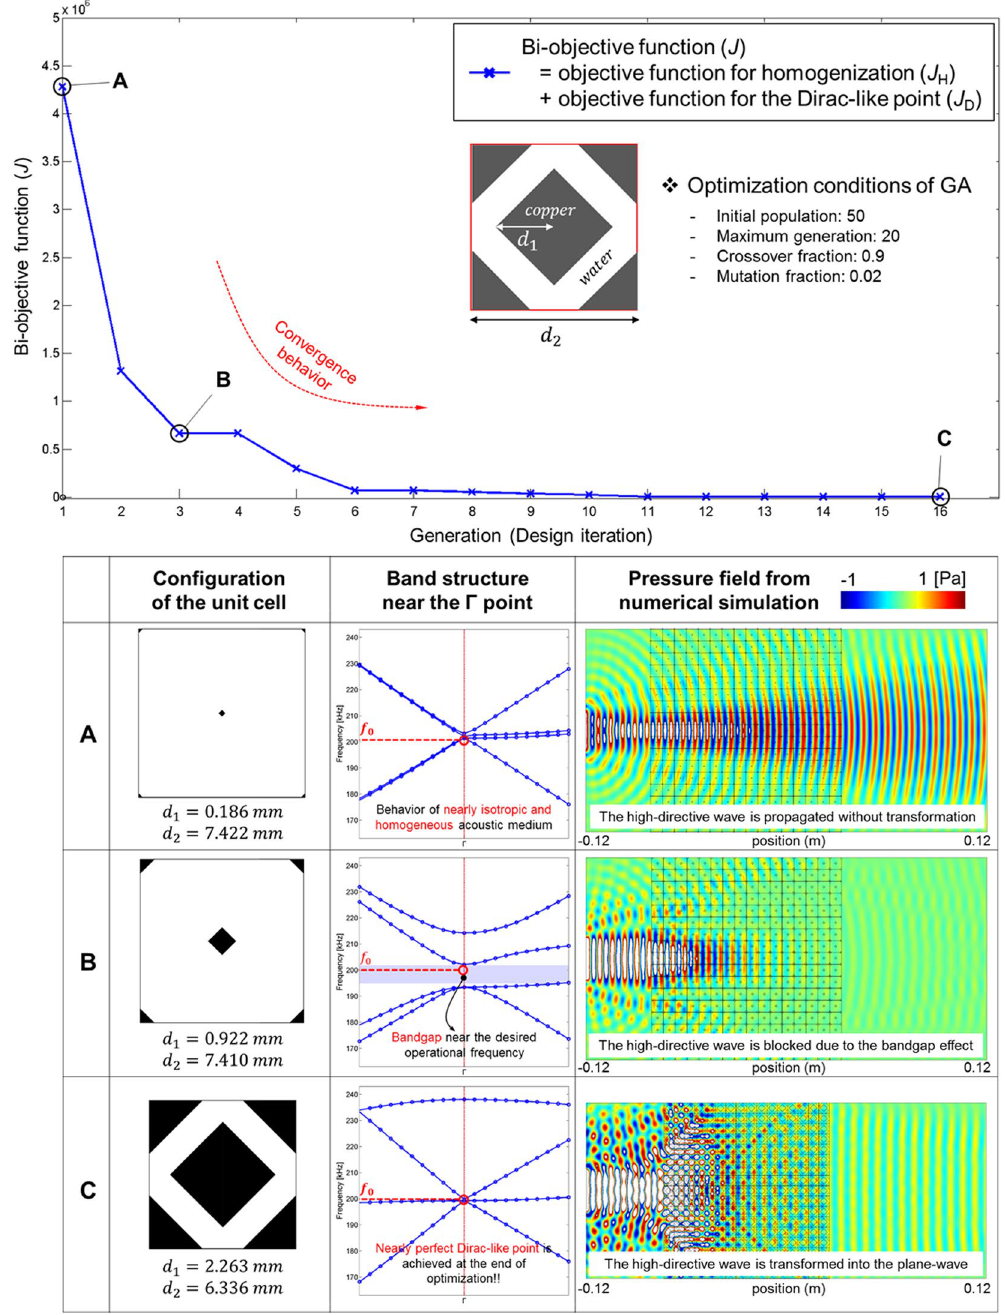
Figure 3. Optimization history of the DZIPnC with a square-shaped hard inclusion. Upper panel: the bi- objective value in an optimization history plot with respect to the design iterations. The inset shows the target unit-cell shape parameterized by two design variables. Lower panel: results at three iteration points in the optimization history. The figure shows the configurations of the unit cell (left), the band structures near the Γ point (middle), and the simulated pressure fields (right). The evolution of the configuration of the unit cell is evident and the configuration in step C is the unit-cell shape of the DZIPnC optimized from the GA